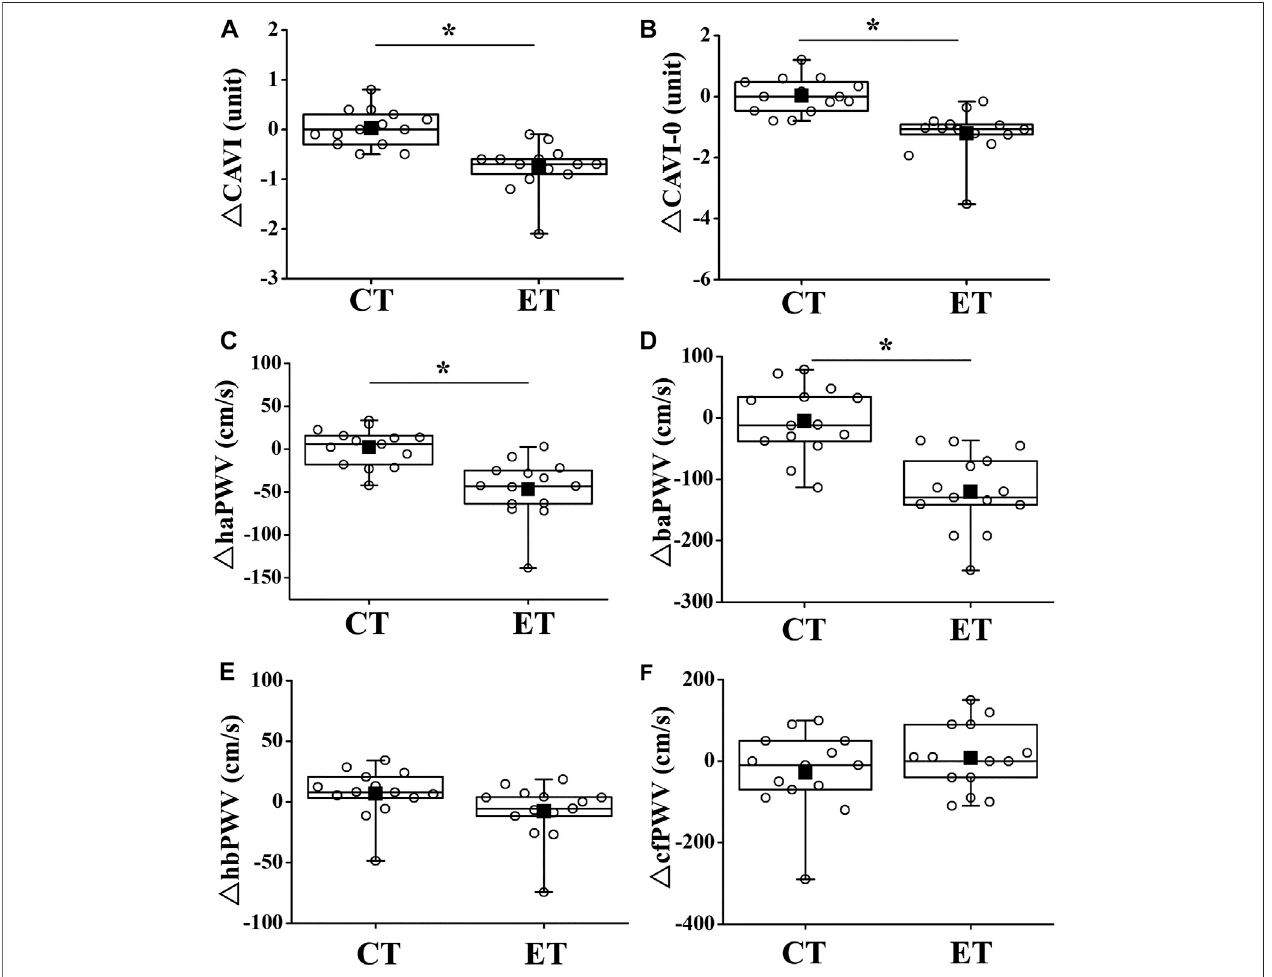
FIGURE 5 | Comparisons of change in arterial stiffness between CT and ET. Box-and-whisker plots indicate that the horizontal bar within the box denotes the median value. The top and bottom borders of the box mark the 75th and 25th percentiles. The ends of the whiskers are drawn to the minimum and maximum points. Filledsquares ( ■ ) and opencircles ( ○ )show meanvalue andpersonalvalues, respectively.CT,controlrestingtrial;ET,electricalstimulation trial.Abbreviationsforarterial stiffness parameters are the same as in Figure 4 . p p < 0.01 vs. CT.